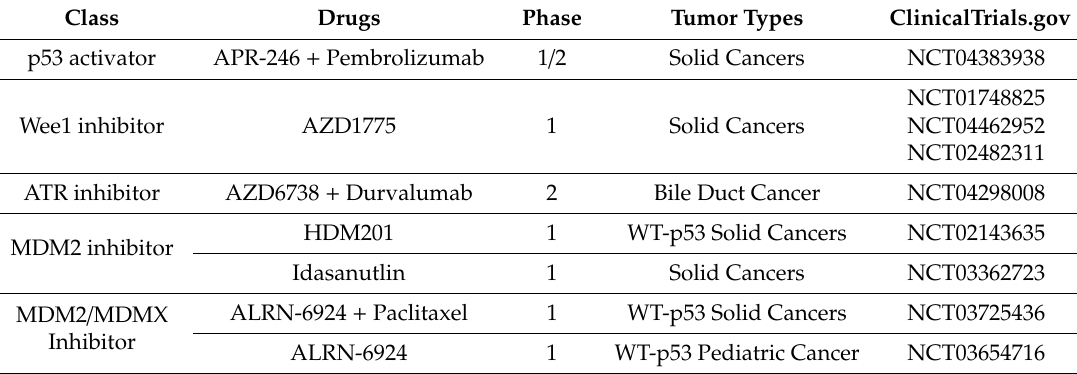
Table 1. Selected clinical trials targeting the p53 pathway in solid